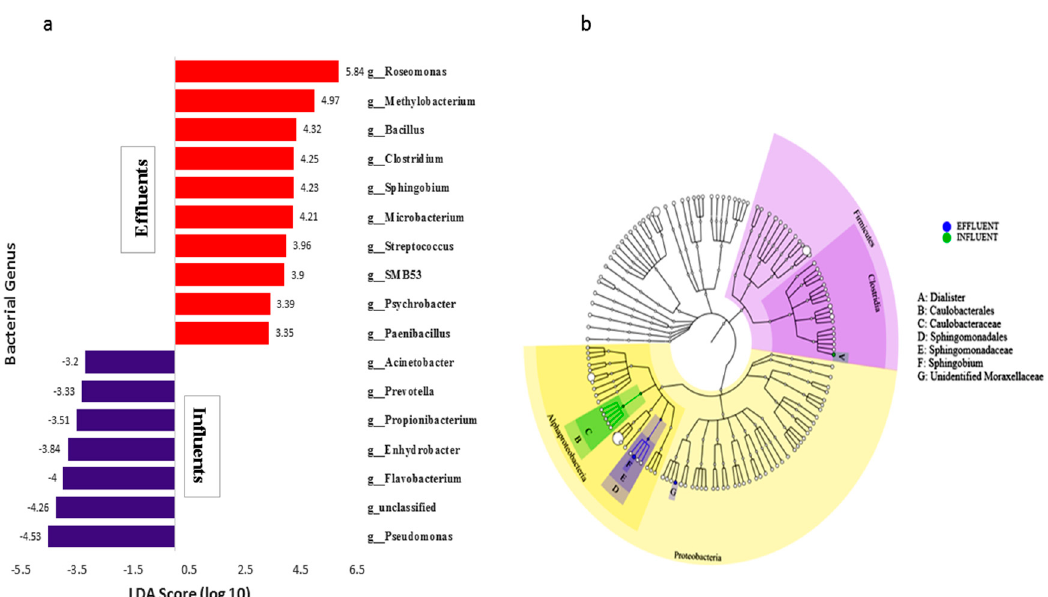
Figure 5. ( a ) Linear discriminant analysis (LDA) effect size (LEfSe) analysis showed differentially abundant genera as biomarkers determined using the Kruskal–Wallis test ( p < 0.05), with LDA scores > 3.5. ( b ) Cladogram representation of the differentially abundant orders, families, and genera. The root of the cladogram denotes the domain Bacteria, and the size of each node represents its relative abundance.